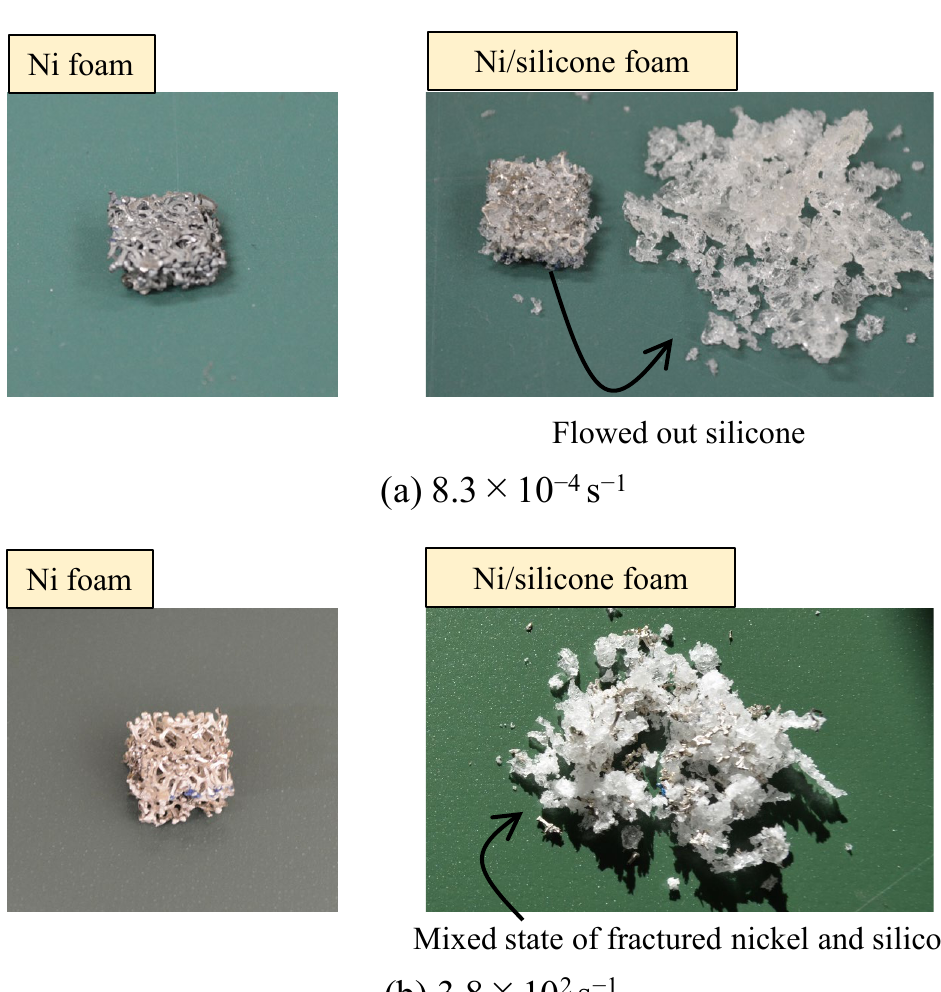
Figure 12. Each specimen after compression test at strain rates of 8.3 × 10 −4 ( a ) and 3.8 × 10 2 s −1 ( b ).